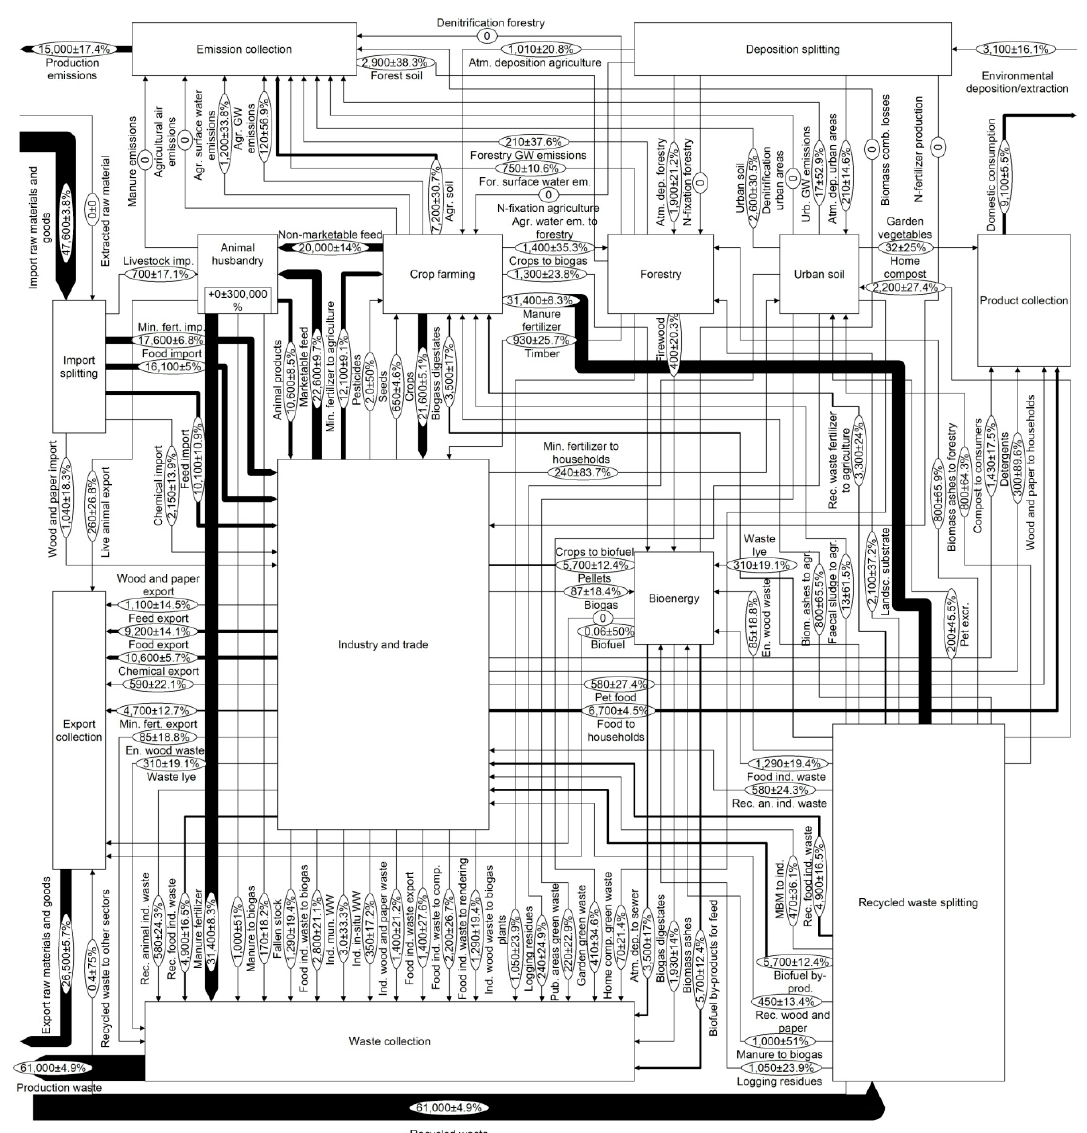
Figure A1. Austrian P system 2015, subsystem production.